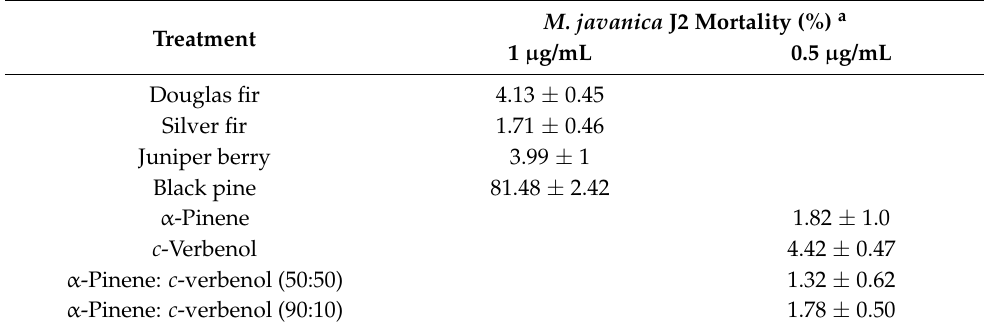
Table 4. Effects of coniferous essential oils on mortality of second stage juveniles (J2) of M. javanica